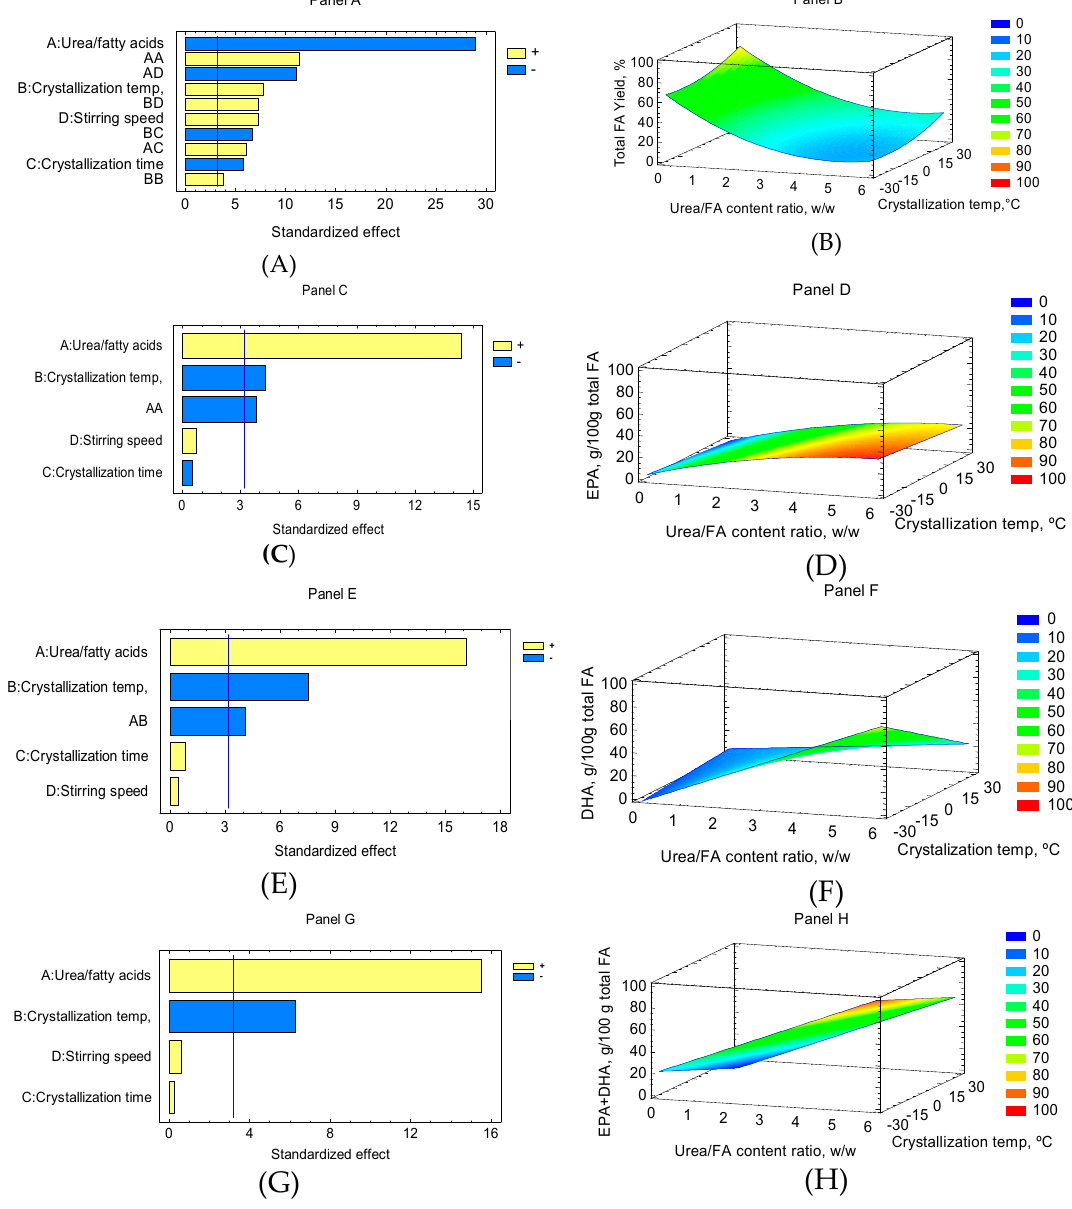
effectC:Crystallization 16 Standardized Figure 1. Pareto charts and response surfaces for the e ff ects of di ff erent process variables: Panels in total FA yield (%, panels A , B ), EPA content (g / 100 g total FA, panels C , D ), DHA content (g / 100 g total FA, panels E , F ), EPA + DHA content (g / 100 g total FA, panels G , H ). A: urea / FA contents ratio, w / w ; B: crystallization temperature, ◦ C; C: crystallization time, h; and D: stirring speed,